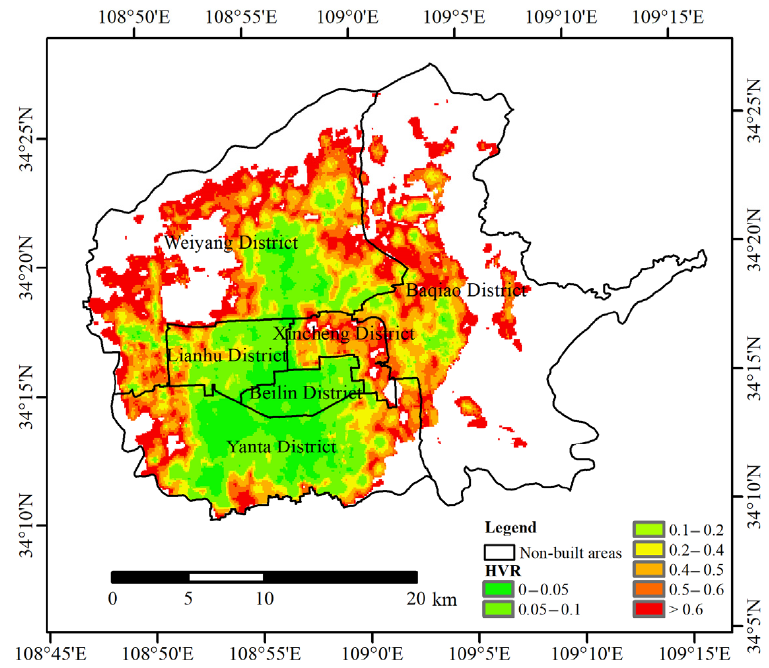
Figure 8. Minimum values of the house vacancy rates in Xi’an city. The results of HVR were grouped by districts, and the average HVR of each district was obtained, which can be seen in Figure 9.